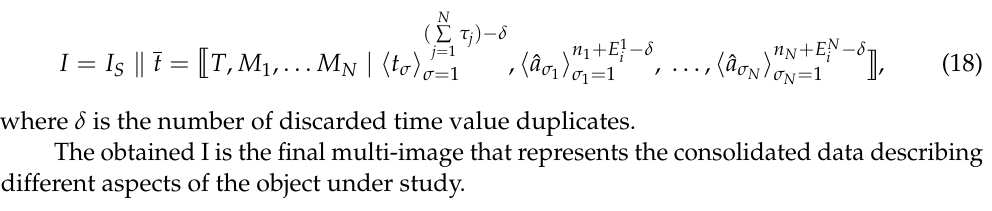
Figure 4. An example of two hiddenly compatible aggregates.